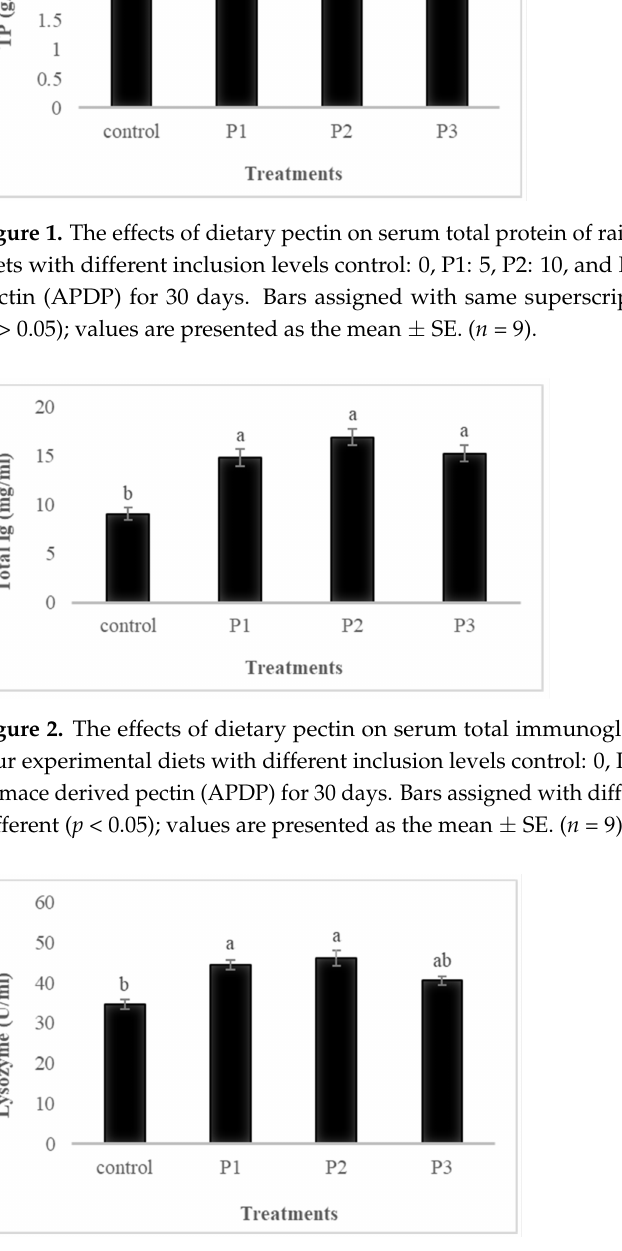
Figure 3. The effects of dietary pectin on serum lysozyme activity of rainbow trout fed four ex- perimental diets with different inclusion levels control: 0, P1: 5, P2: 10, and P3: 20 g of apple pomace derived pectin (APDP) for 30 days. Bars assigned with different superscripts are significantly different ( p < 0.05); values are presented as the mean ± SE. ( n =